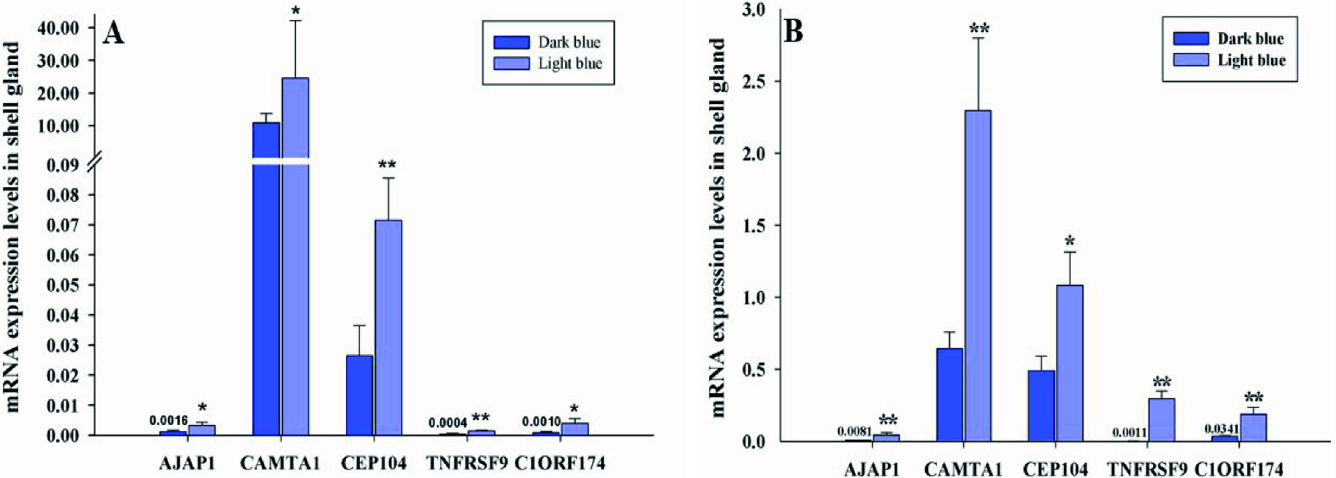
Fig 3. Expression levels of the five candidate genes AJAP1 , CAMTA1 , CEP104 , TNFRSF9 , and C1ORF174 in dark and light blue-shelled chickens. (A) the N146 population, (B) the N280 population. Note error bars represent the mean ± SE. � denote the difference of expression level with significant difference (P < 0.05). �� denote the difference of expression level with significant difference (P <